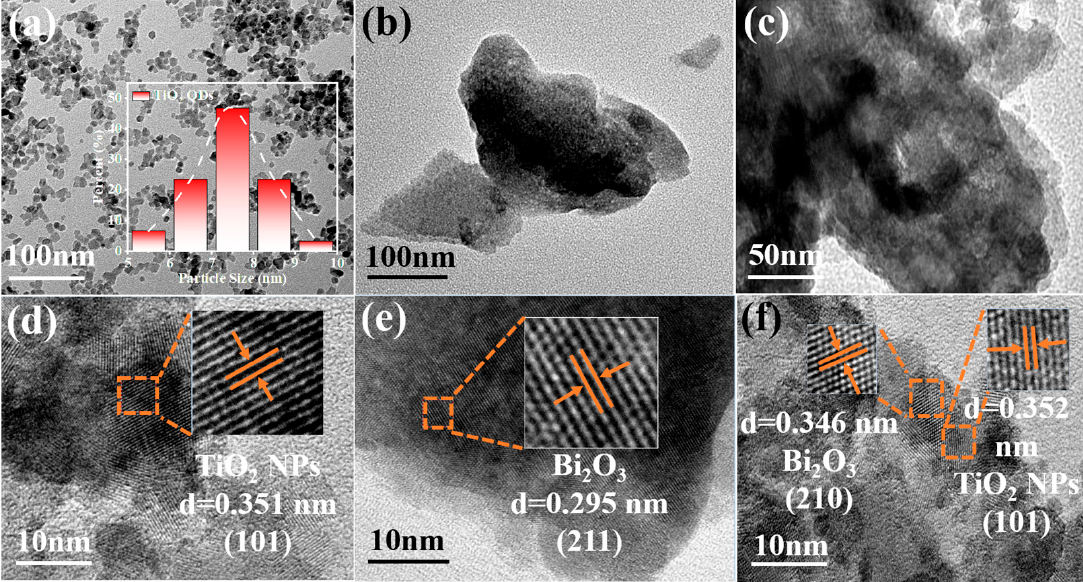
Figure 4. TEM and HR-TEM images of ( a , d ) TiO 2 NPs, ( b , e ) Bi 2 O 3 , ( c , f ) TB-3.